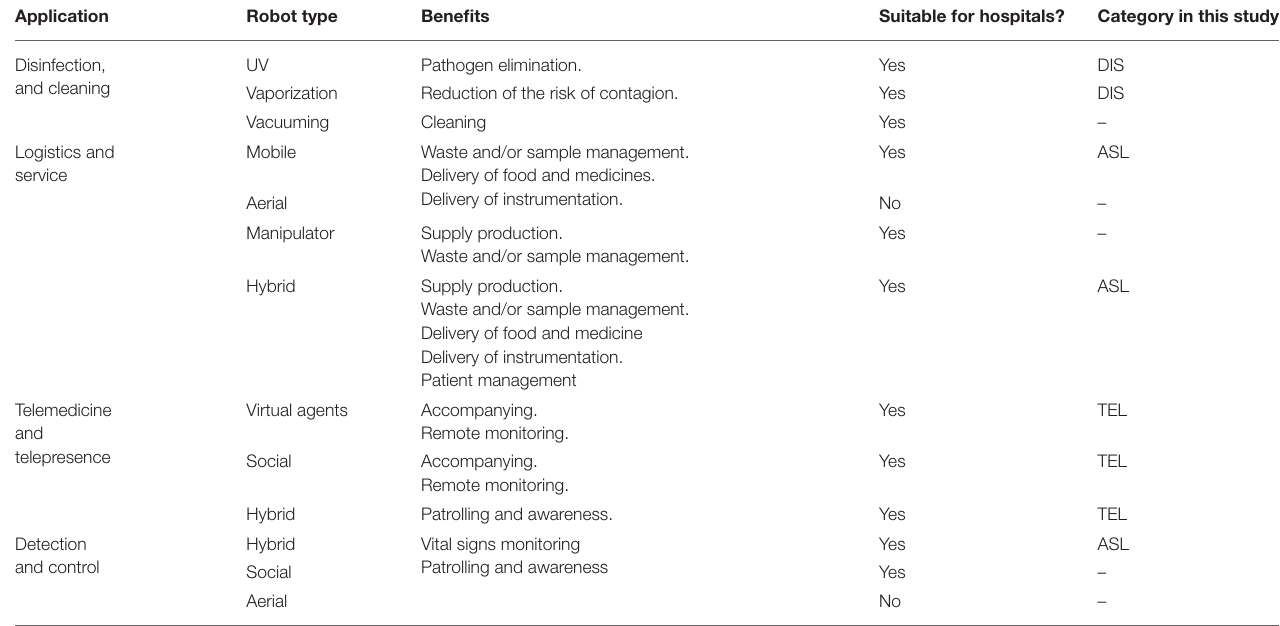
TABLE 1 | Medical robotics applications that are potentially useful in combating the spread of COVID-19.